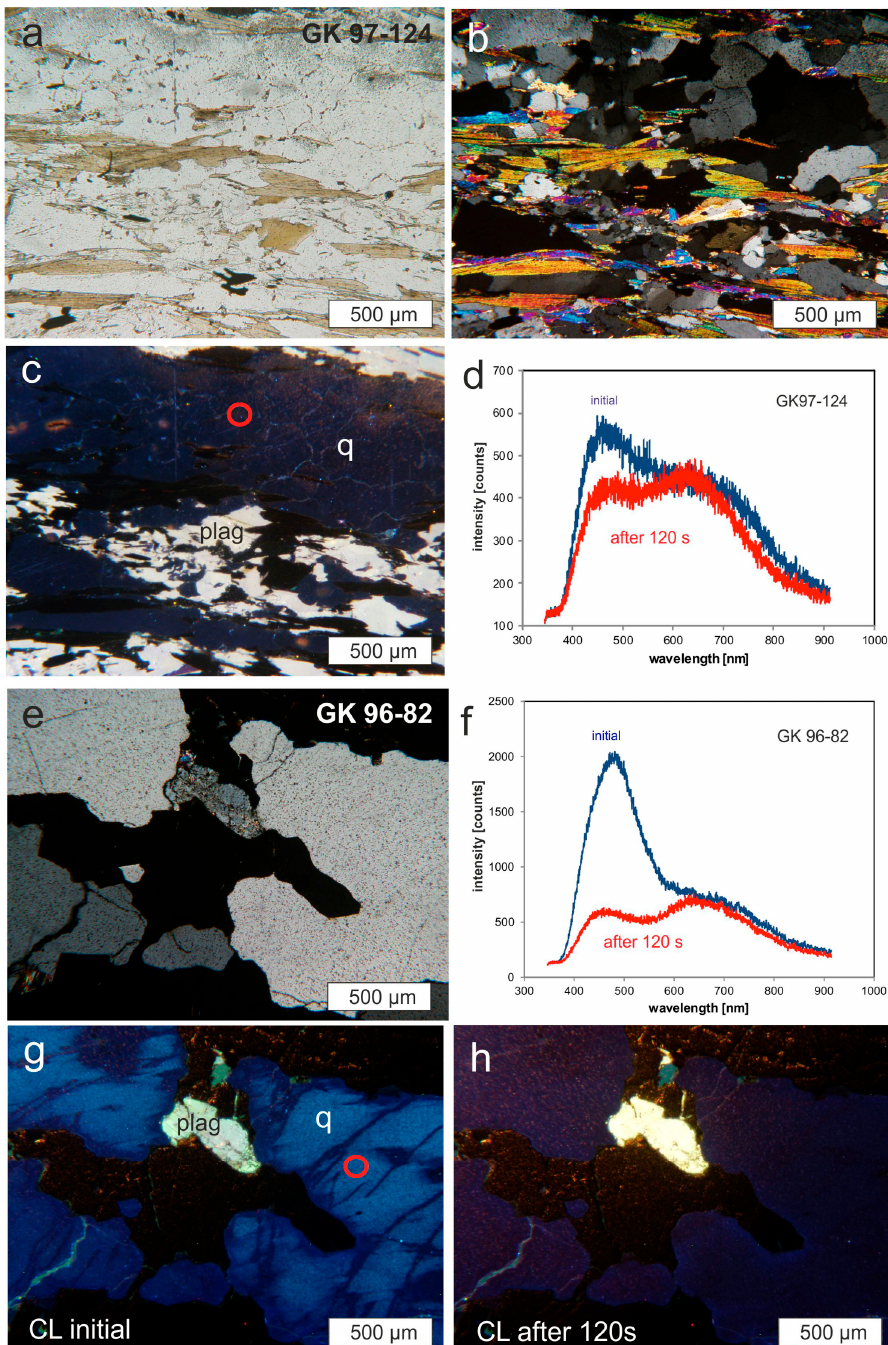
Figure 3. Polarized light and CL micrographs of two investigated metamorphic rocks from the garnet zone showing different luminescence characteristics; ( a , b ) transmitted light and polarized light micrographs of sample GK 97-124; ( c ) CL image of the same sample area showing dark blue CL of quartz (q) and bright CL of plagioclase (plag), mica is non-luminescent; the circle marks the spot for CL spectroscopy; ( d ) related CL emission spectra of sample GK 97-124; ( e ) micrograph in polarized light of a quartz-rich area in sample GK 96-82; ( f ) CL emission spectra of quartz in sample GK 96-82 showing a dominant initial emission band at ca. 490 nm and the spectrum after 120 s of electron irradiation; ( g , h ) CL images of sample GK 96-82 initially and after 120 s of electron irradiation; the short-lived blue-green CL of quartz (q) disappears and turns to a weak violet CL.